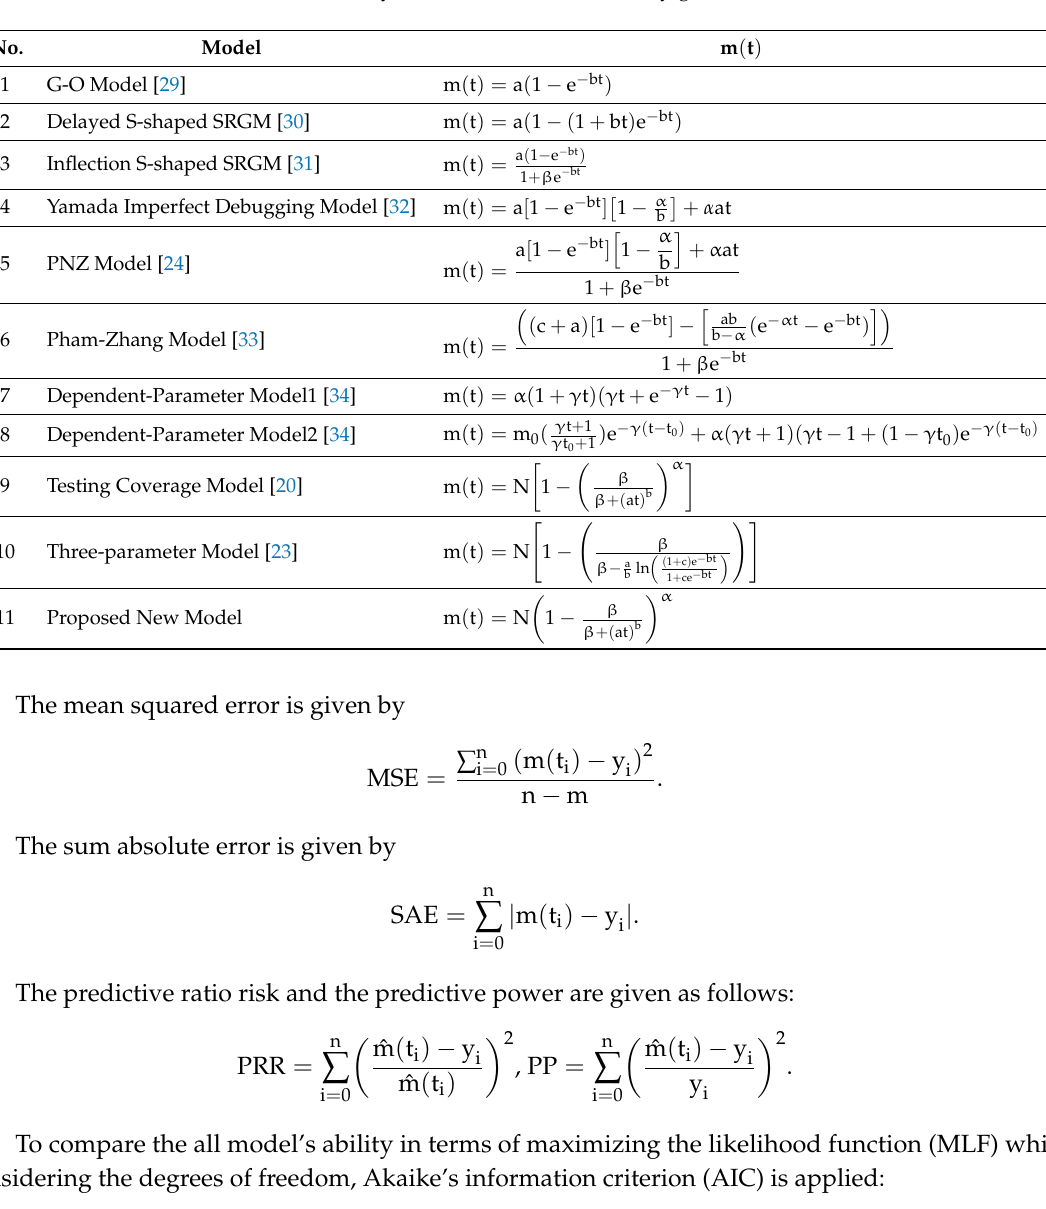
Table 1. Software reliability models. Software reliability growth model